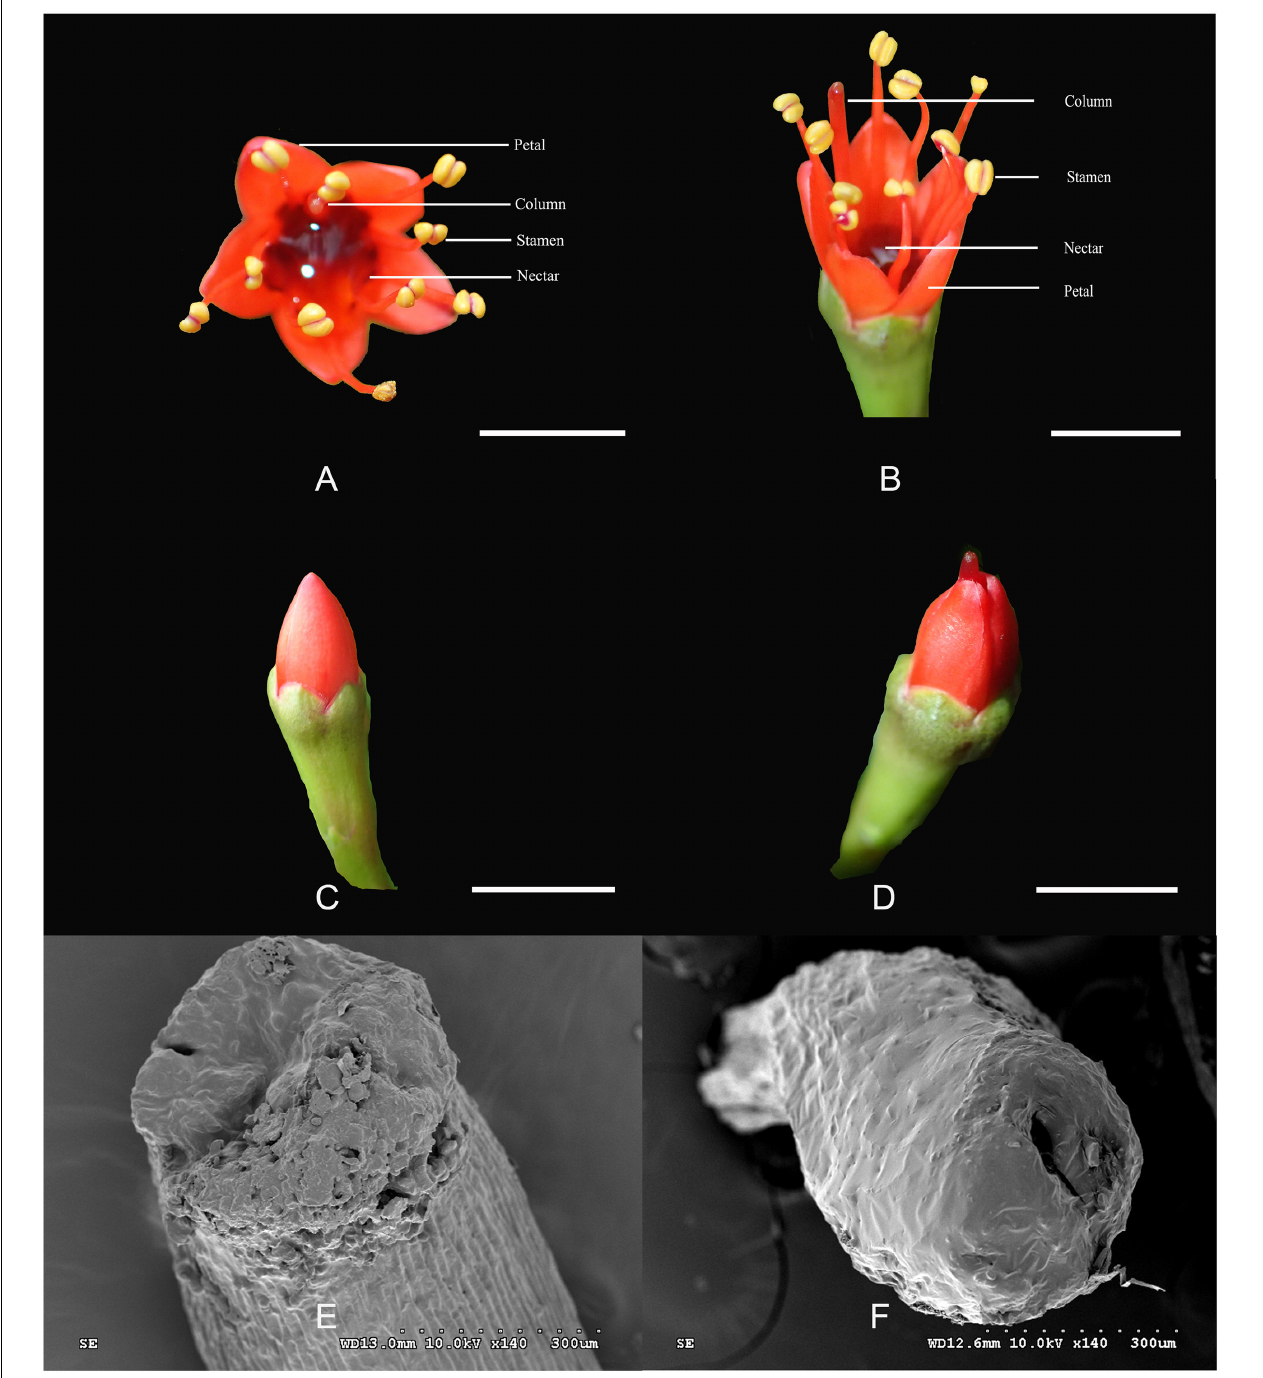
FIGURE 1 | The structure of flowers in Lumnitzera littorea . (A,B) Hermaphroditic flower; (C) L-1: column into a petal; (D) L-2: column stretched beyond the petals; (E) No pistillar chord on stigma; (F) Pistillar chord on stigma.